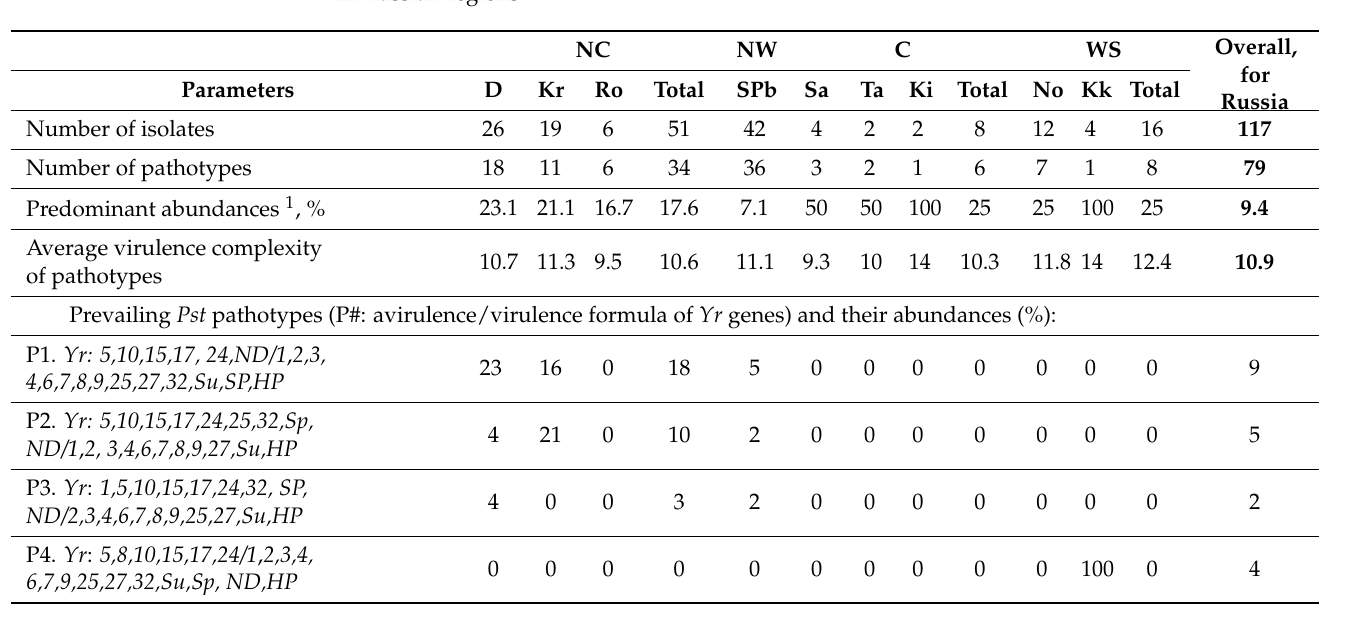
Table 4. Pathotypes of Puccinia striiformis identified among isolates originating from common wheat in Russian